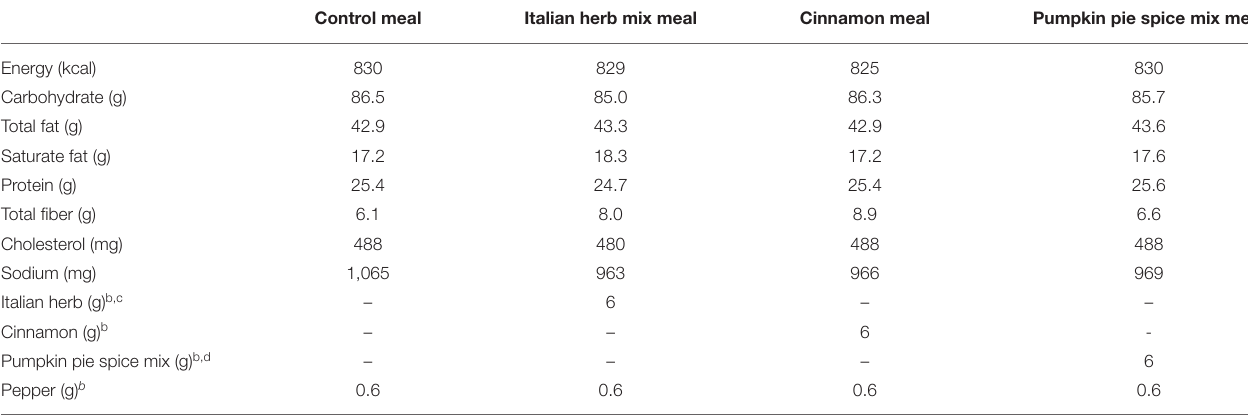
TABLE 1 | Composition of high-fat, high-carbohydrate (HFHC) breakfast test meals a for postprandial study